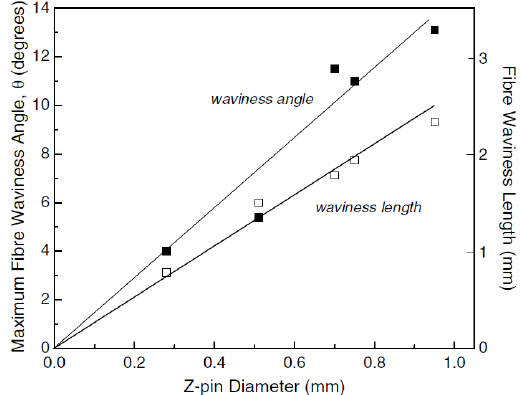
Figure 4. Plot of z-Pin diameter on the deflection angle and length of wavy region in a unidirectional carbon/epoxy composite [1].